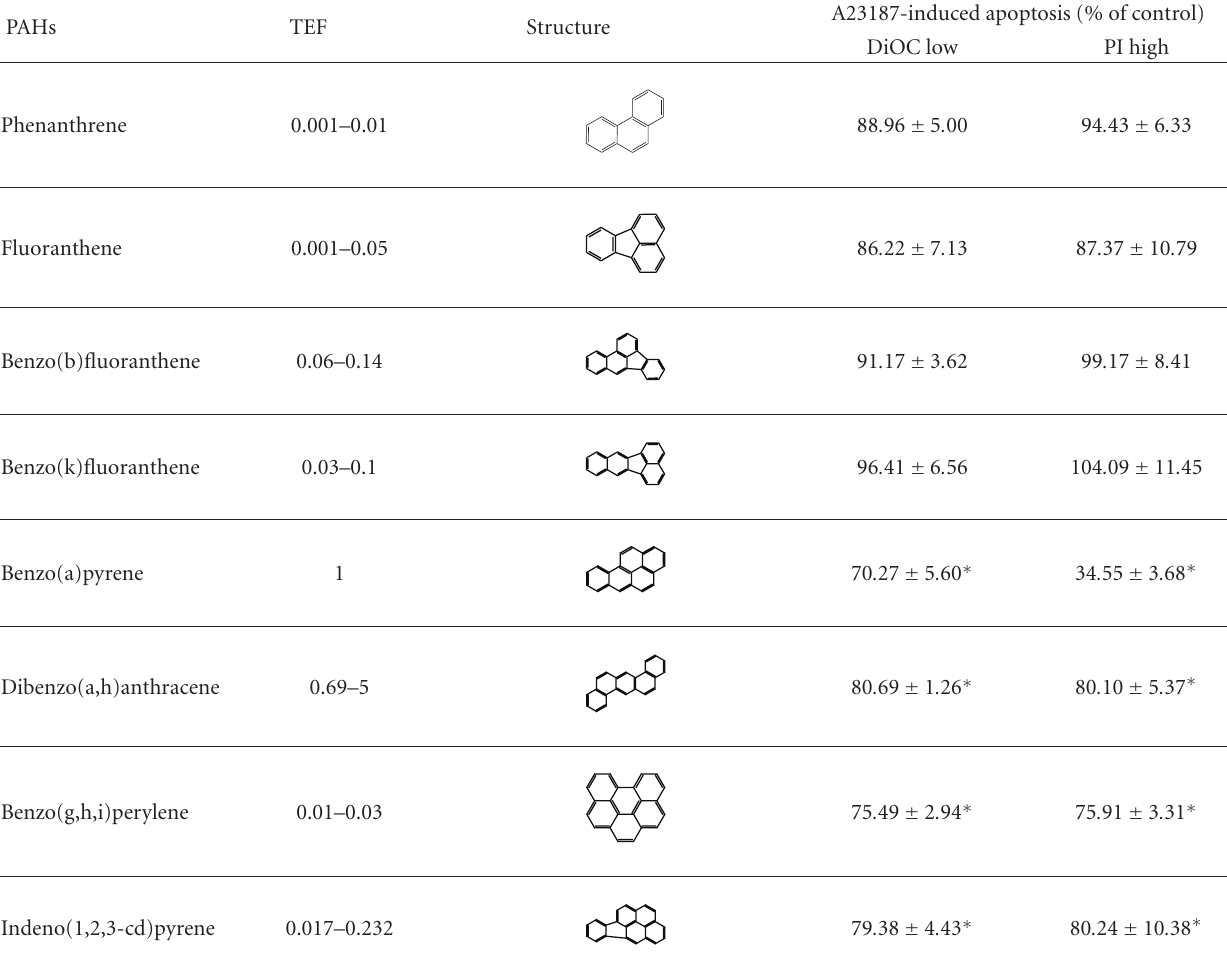
Table 2: The cytoprotective e ff ect of PM 2 . 5 is related to PAHs with five-aromatics rings. Epithelial 16 HBE cells were pretreated during 4 hours with phenanthrene (124 nM), fluoranthene (268nM), benzo(b)fluoranthene (333nM), benzo(k)fluoranthene (333 nM), benzo(a)pyrene (270nM), dibenzo(a,h)anthracene (35nM), benzo(g,h,i)perylene (443 nM), and indeno(1,2,3-cd)pyrene (217nM) prior to induction of apoptosis by A23187 (3 μ M) for 20 supplementary hours. Results are mean ± SD ( n = 6). Significance was calculated with Dunnett’s test ( ∗ P < 0 . 01 versus vehicule cyclohexane 1%). Percentages of DiOC low and PI high refer to cells showing either a drop of ΔΨ m or